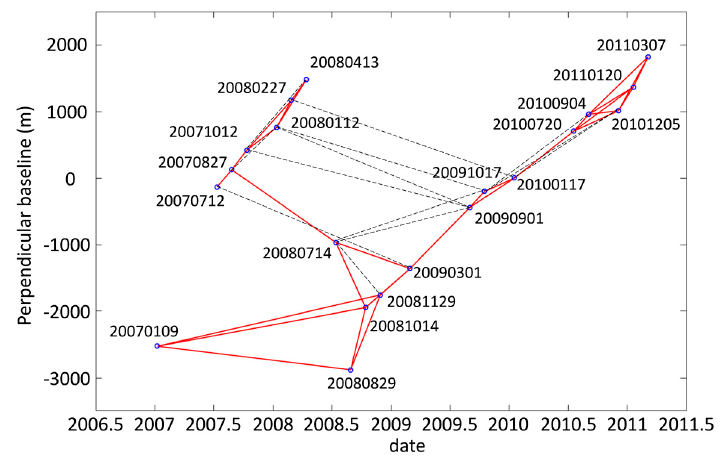
Figure 2. The combination of synthetic aperture radar (SAR) interferometric pairs with respect to the temporal and spatial baselines, where solid lines show accepted interferograms, while dashed lines indicate removed interferograms.